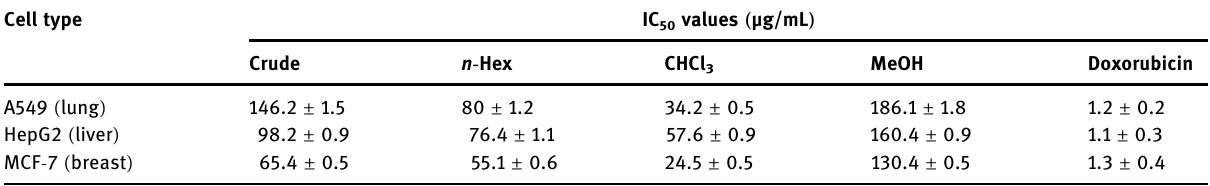
Table 1: IC 50 values of the J. phoenicea crude extract and various fractions against lung, liver, and breast cancer cells Cell type